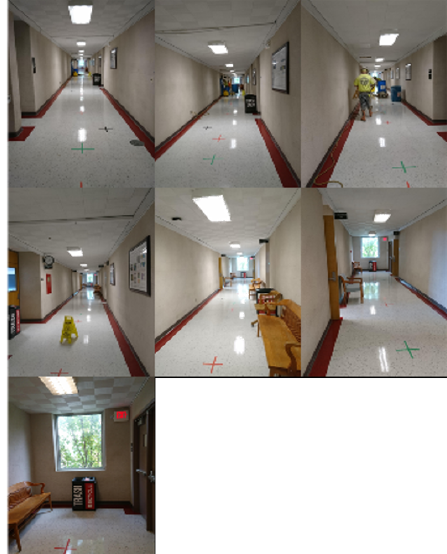
Figure 8. Query images took by SONY smartphone on 7 black test points.